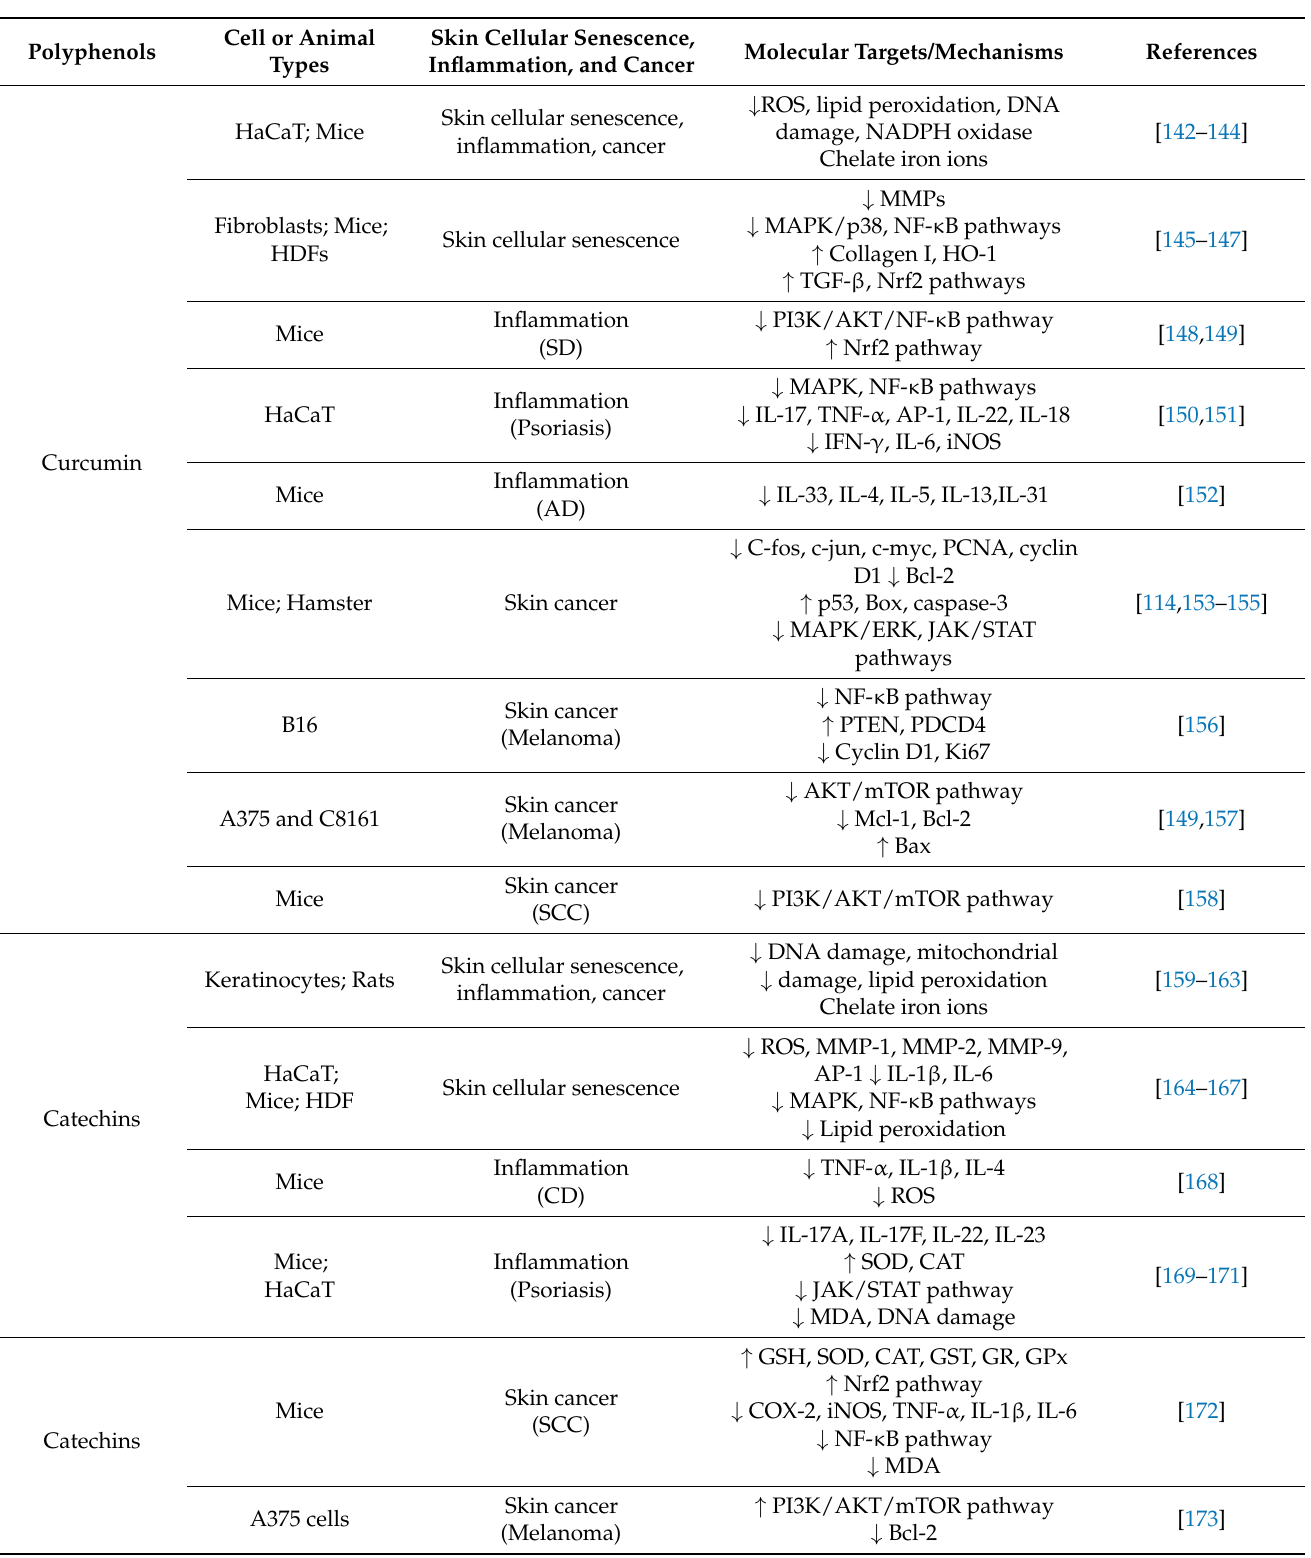
Table 2. A summary of molecular targets of several polyphenols in preventing skin cellular senes- cence, inflammation, and